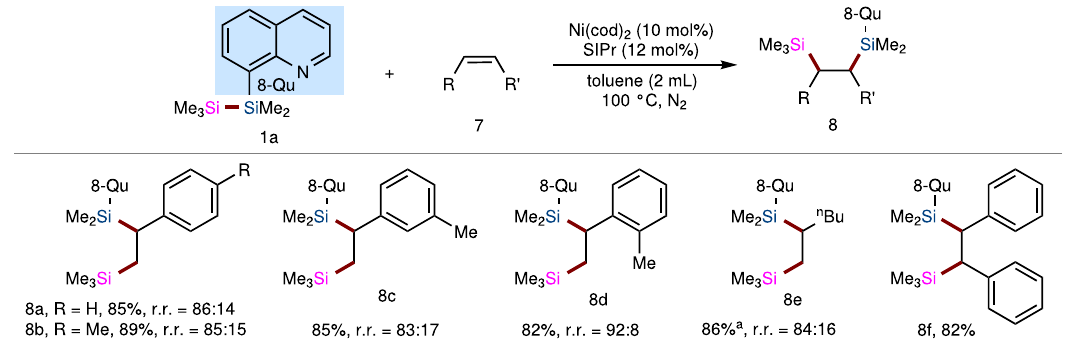
Fig. 5 The bis-silylation reaction of TMDQ reagent 1a with alkenes 7. Standard reaction conditions: the mixture of Ni(COD) 2 (5.6 mg, 0.02 mmol) and SIPr (9.5 mg, 0.024 mmol) in toluene (2 mL) was stirred for 30 min, then disilane reagent 1 (0.2 mmol) and speci fi c alkene 7 (0.4 – 2 mmol) were added. The reaction was heated to 100 °C with vigorous stirring for 48 h under N 2 atmosphere. See Supplementary Information (SI) for details. a 10.0 equiv alkene was used.